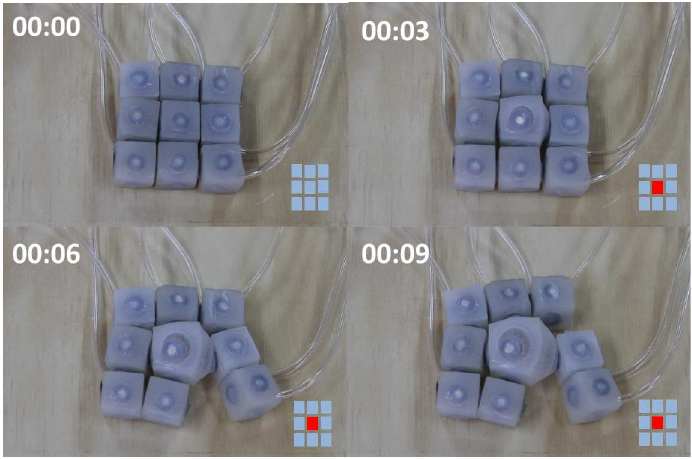
Fig 7. Cell Delamination. A sequenceof images showinga behavior that resemblescell delamination on a modularsystem constructed with nine units. The sequenceillustrates how inflationon a central module produces two detachmentson the lower right portion of the